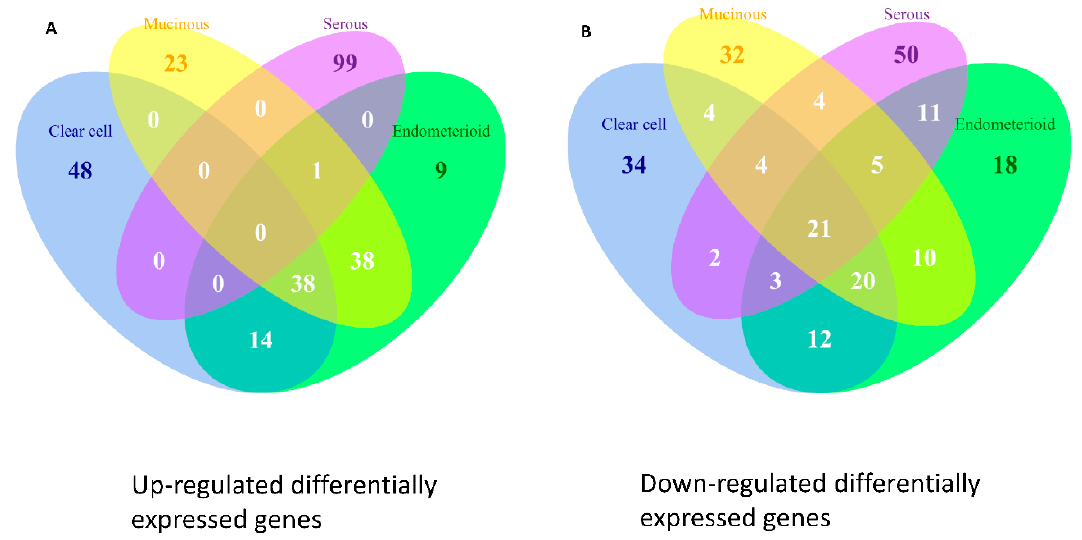
Figure 7. Venn diagram of the top 100 up- and down-regulated differentially expressed genes (DEGs) for the four subtypes. The results of set analysis for the four ECO subtypes with ( A ) the top 100 up-regulated; and ( B ) top 100 down-regulated DEGs were ranked by the p values, and the DEG numbers of all possible logical relationships among the four subtypes were shown.